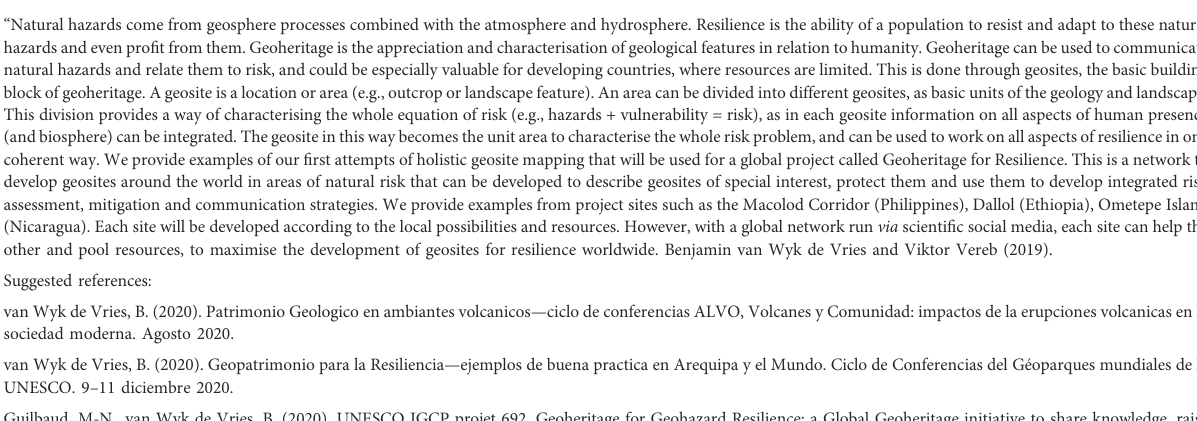
TABLE 3 Theoretical framework for Geoheritage for Geohazard Resilience in Arequipa.